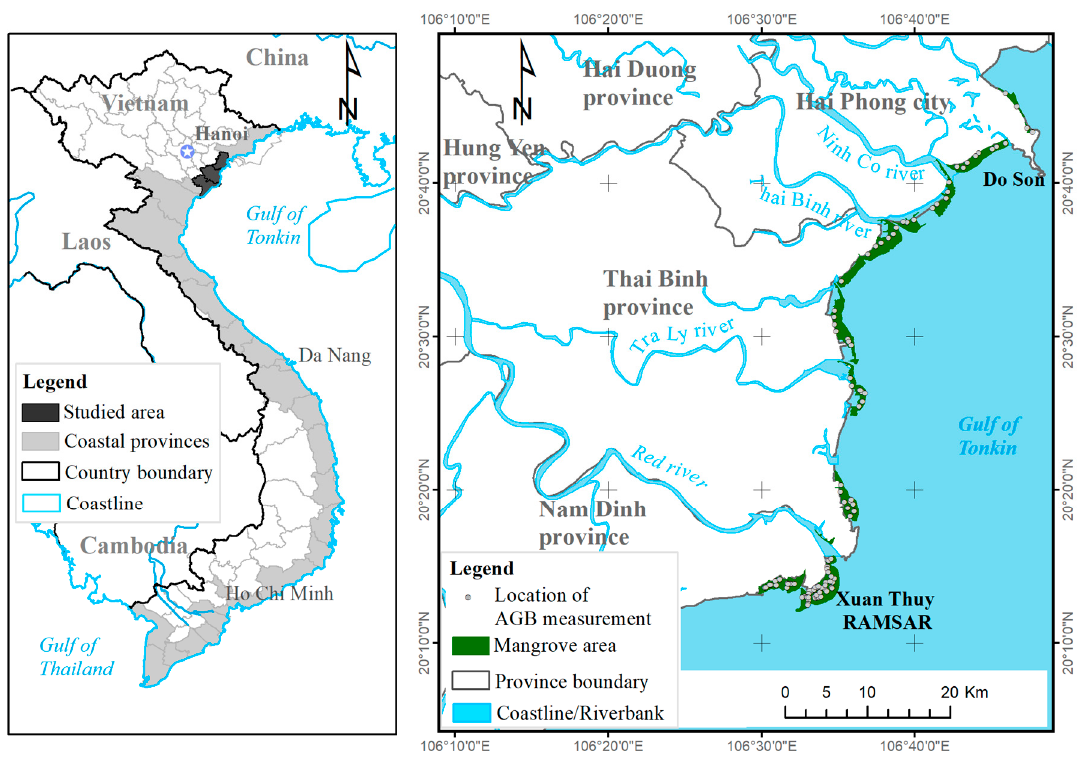
Figure 1. Location map of the mangrove study areas.